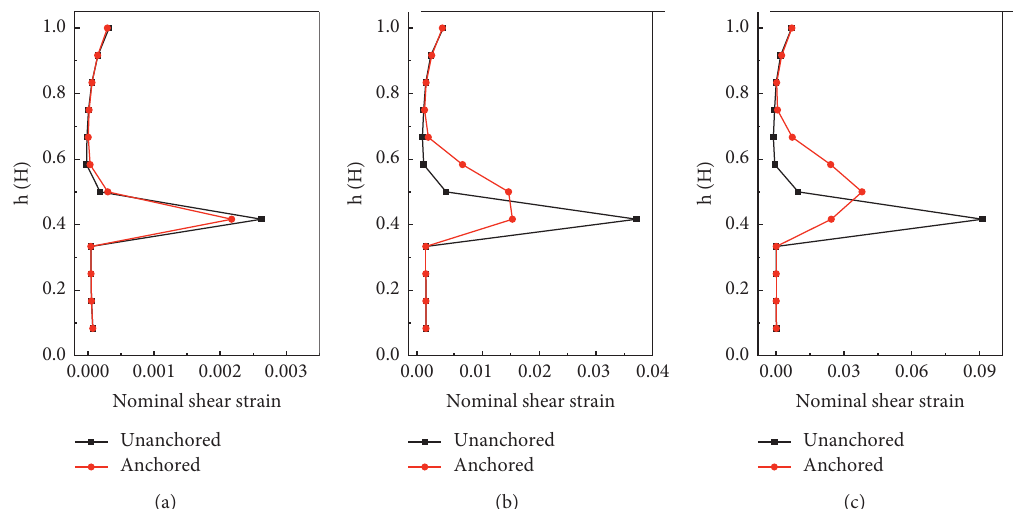
Figure 8: Nominal shear strain distribution along the elevation of the slope surface with different amplitudes: (a) amplitude is 0.5 m/s 2 ; (b) amplitude is 1.0m/s 2 ; (c) amplitude is 1.5m/s 2 .